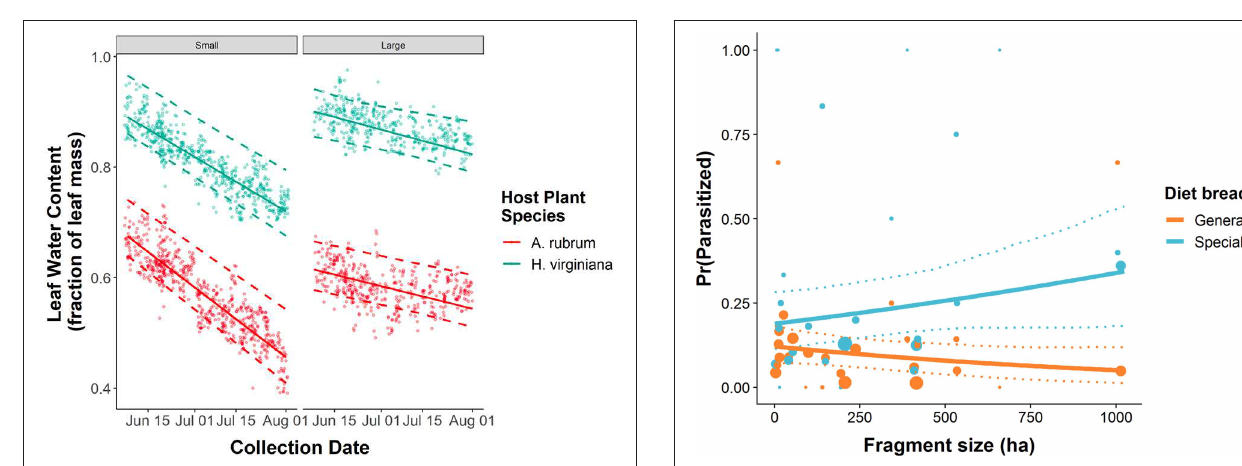
FIGURE 5 | Seasonal declines in leaf water content of Acer rubrum and Hamamelis virginiana trees in relation to forest patch size. Solid lines represent the predicted values from GLMMs, dashed lines represent 95% confidence intervals around the predictions, and points are the raw data.